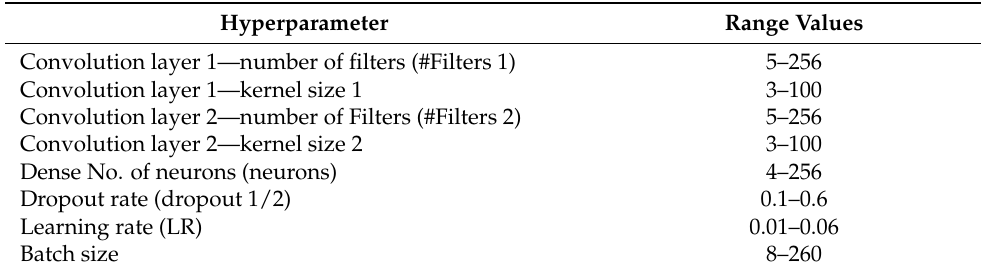
Figure 1. One-dimensional convolutional neural network architecture design. Table 2. Bayesian optimization hyperparameter